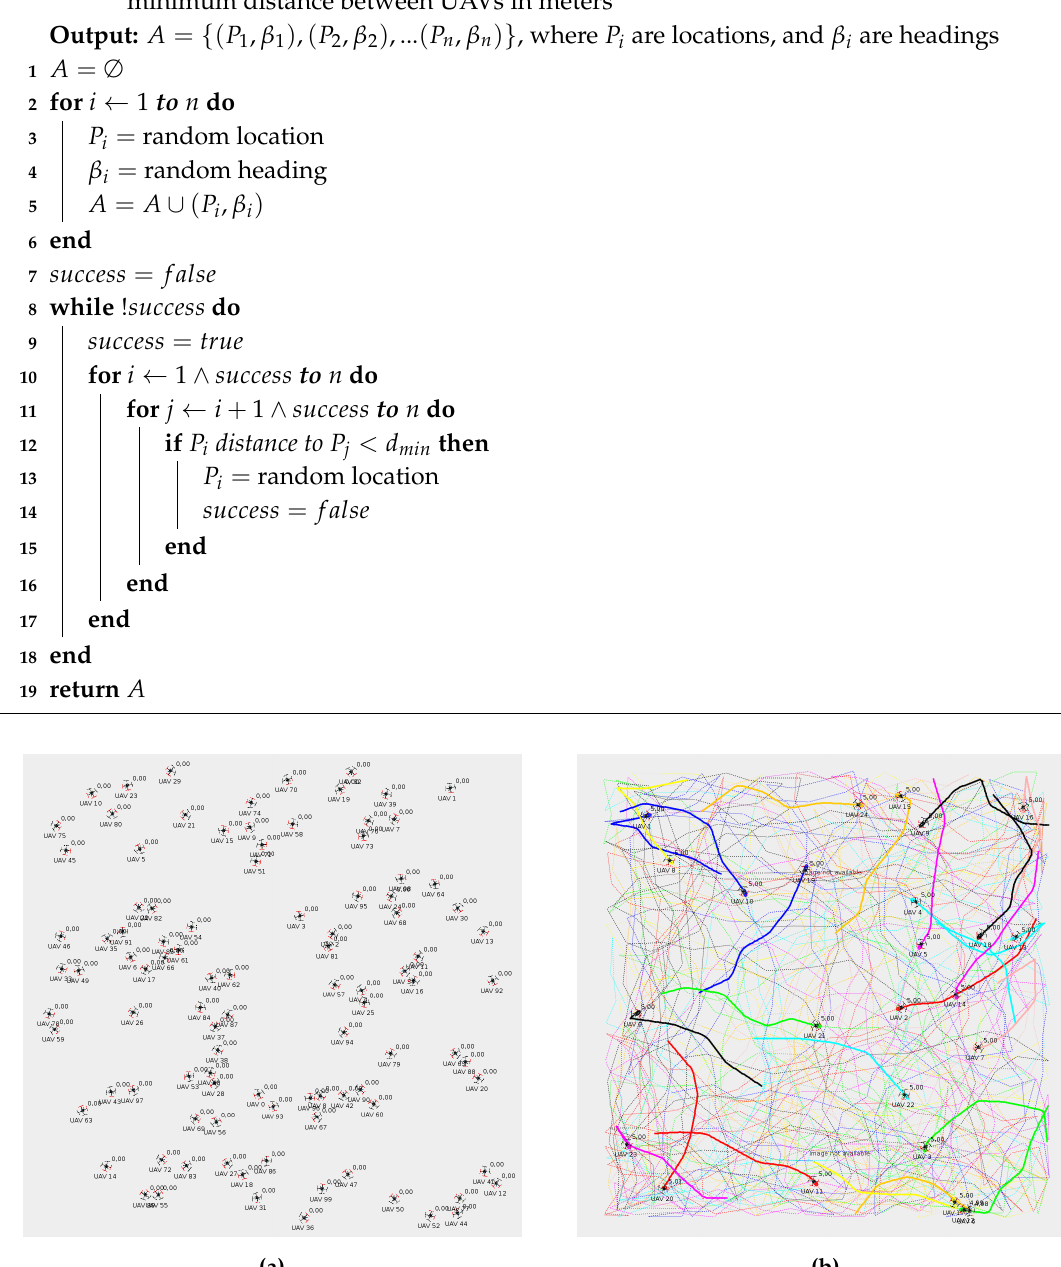
Algorithm 1: R AN L OC Returns a Random Initial Location and a Random Heading for n UAVs.